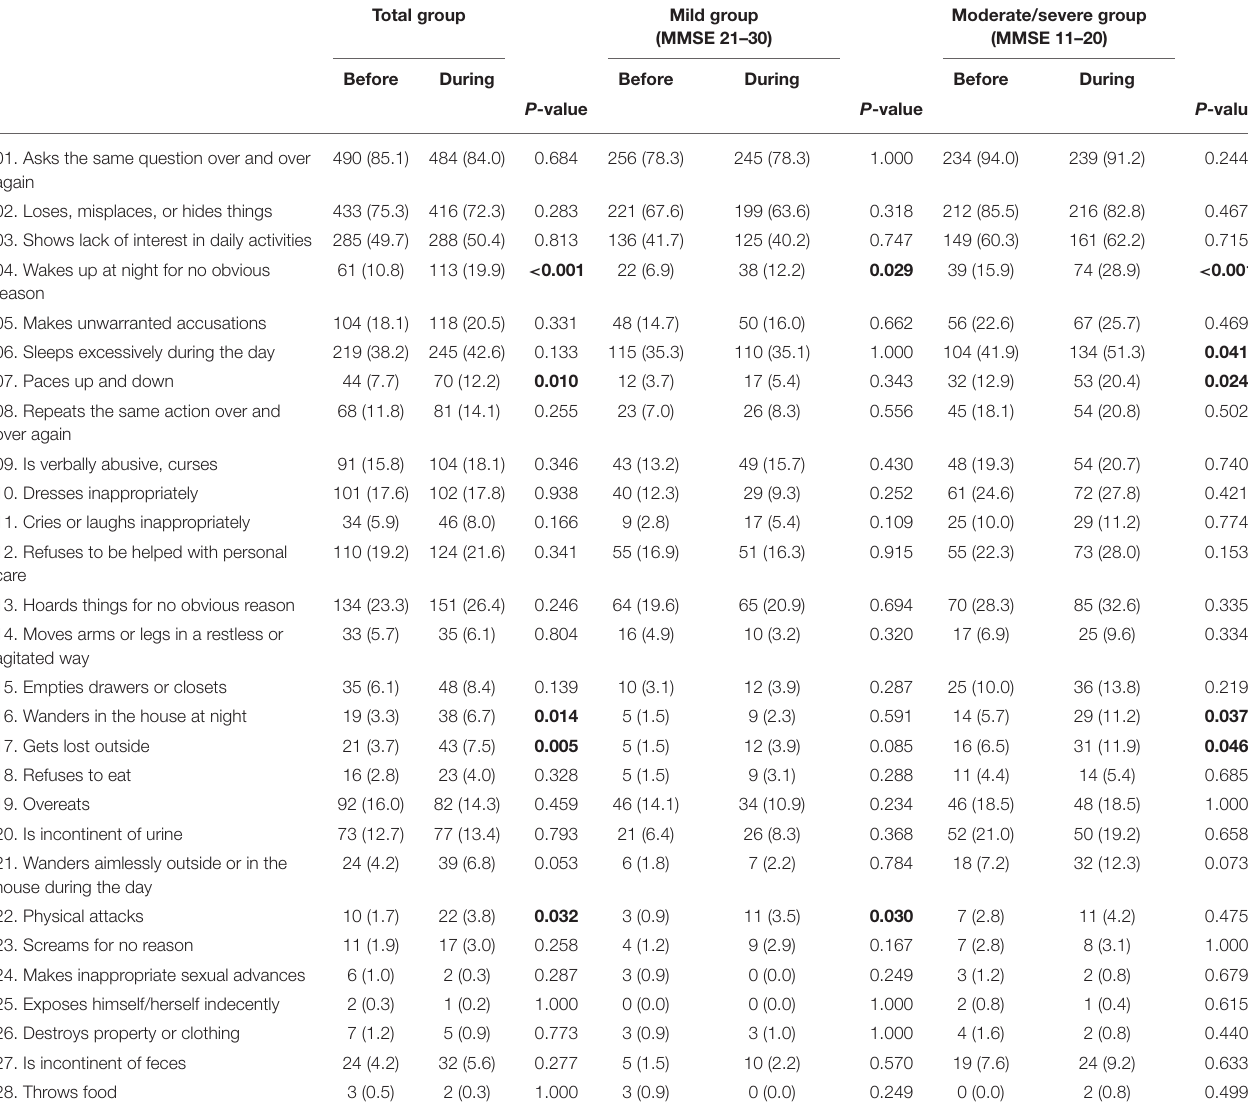
TABLE 2 | Proportion of patients with behavioral disorders in each item of DBD: before and during COVID-19 pandemic, by severity of cognitive impairment. Total group Mild group Moderate/severe group (MMSE 21–30) (MMSE 11–20) Before During Before During Before During P -value P -value P